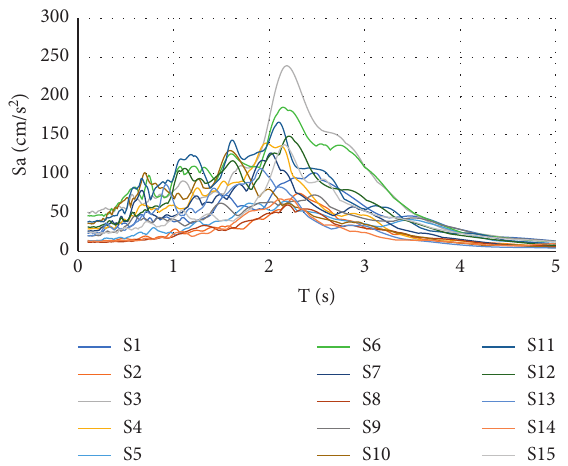
Figure 7: Seismic response spectra of the selected ground motions for soft soil with Ts � 2.0.